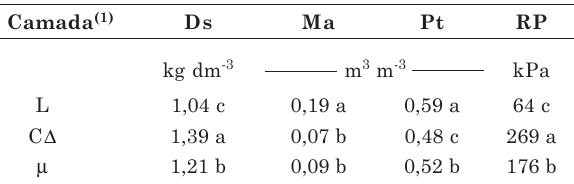
visível a olho nu e abundante presença de raízes; C ∆ , a camada de solo com estrutura maciça e homogênea, sem porosidade visível a olho nu e menor presença de raízes em relação à camada L; e µ , a camada de solo com estrutura na forma de grânulos e de blocos, típica de Latossolo. Médias seguidas por letras iguais, na coluna, não diferem entre si pelo teste de Tukey, a 5